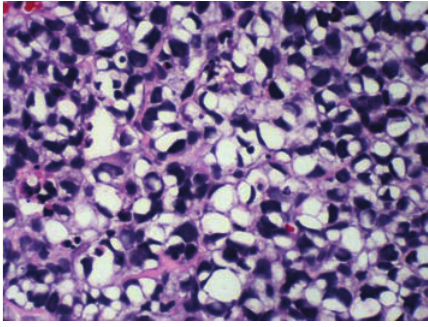
Figure 1: H & E stained cell block (40x).